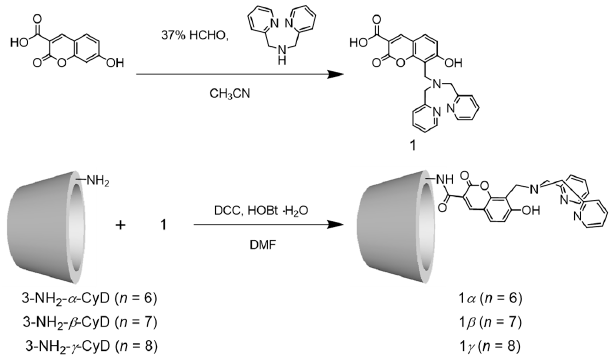
Scheme 1. Synthesis of 1 α , 1 β , and 1 γ ( n : the number of glucose units).